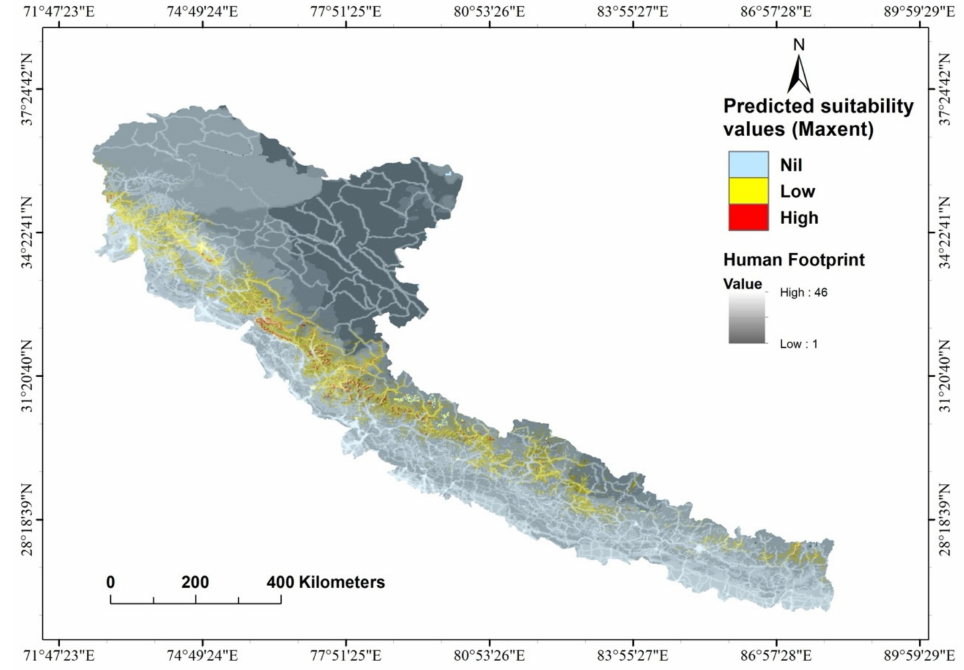
Figure 5. Habitat suitability map of the Cheer Pheasant overlaid on the human footprint index